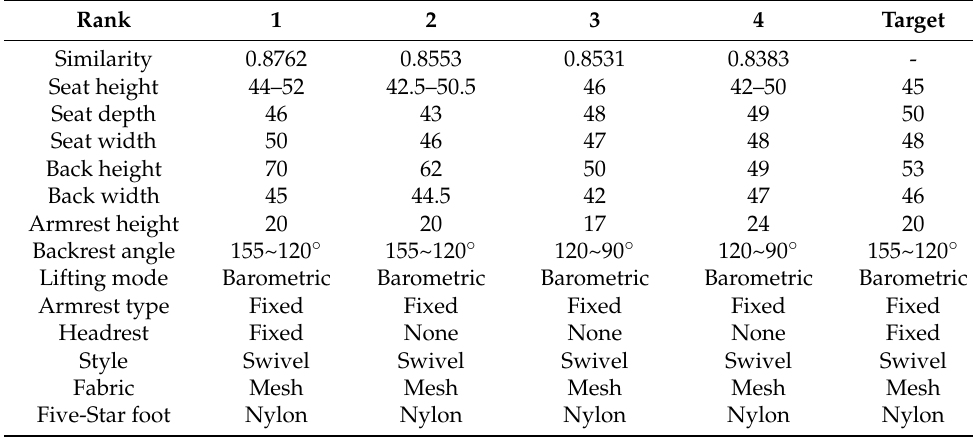
Table 3. The results of K-NN office chair pattern retrieval.